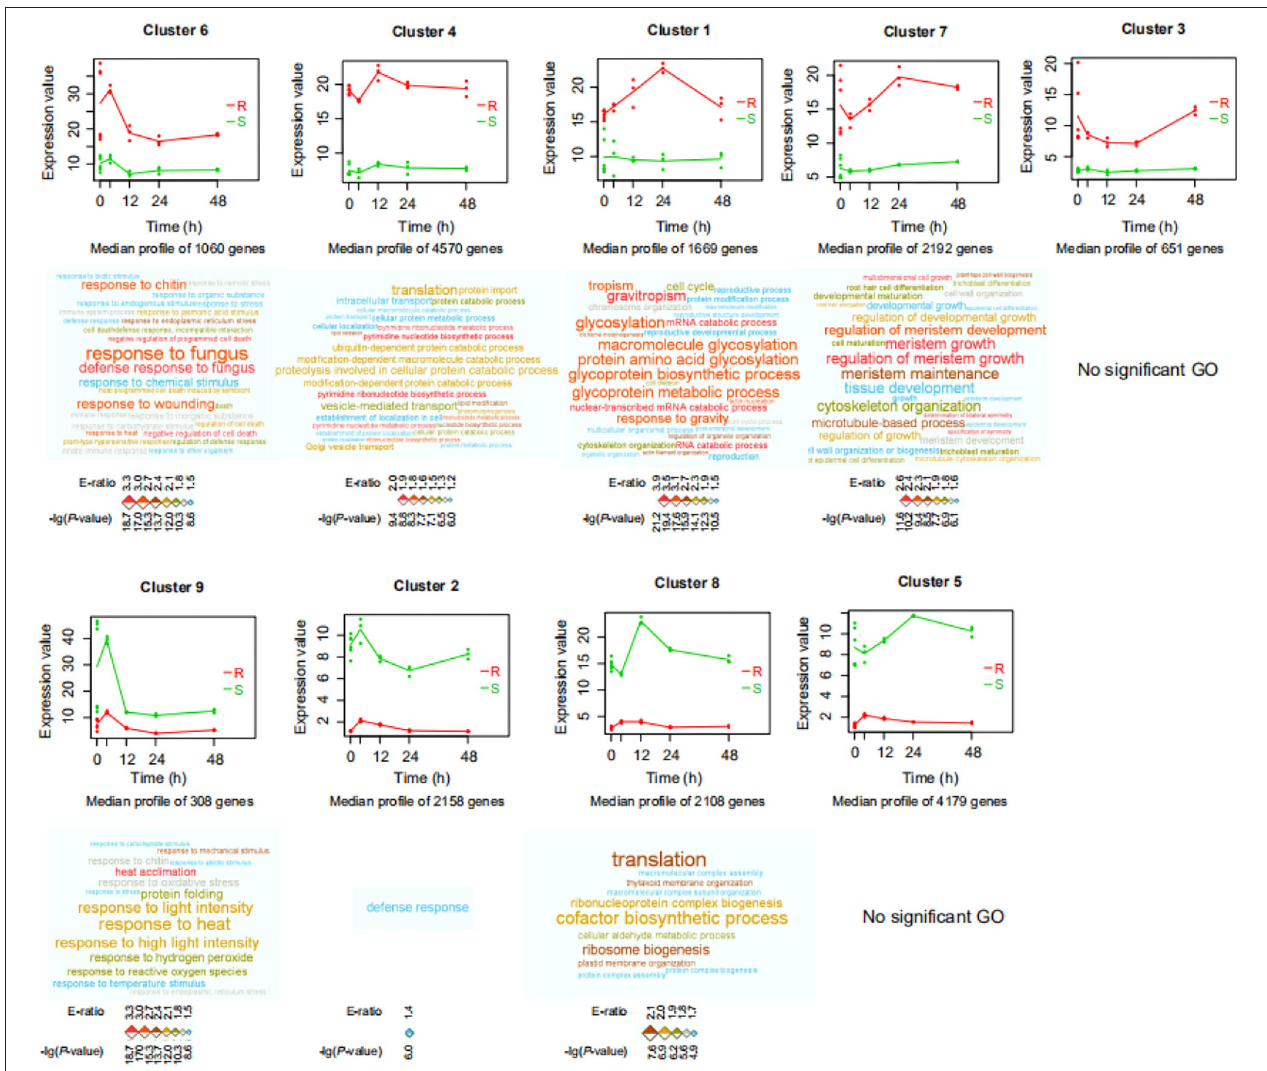
FIGURE 1 | Significant differences in gene expression profiles between resistant (R; P. flaviflorum ) and susceptible (S; P. nigrum ) species of Piper. Expression profile clusters were identified by the maSigPro package from time-course RNA-Seq data of root samples at 0, 4, 12, 24, and 48h post- Phytophthora capsici inoculation. x-axis: time; y-axis: gene expression. Red color indicates the resistant species, and green color indicates the susceptible species; lines represent the average of each time-group so as to visualize cluster-wide trends over time. Gene Ontology (GO) enrichment analysis was performed for the genes in each cluster; enriched biological process terms are visualized as word clouds below the cluster expression plots. Word clouds were generated by the WocEA software; font size and color denote the -log ( P -value) and enrichment ratio (E-ratio),